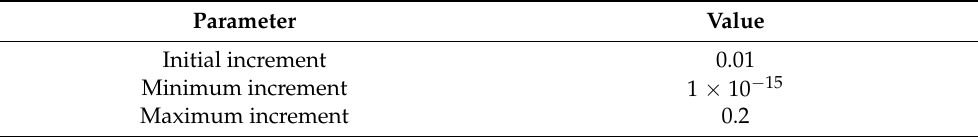
Table 8. Solver parameters for the arc-length